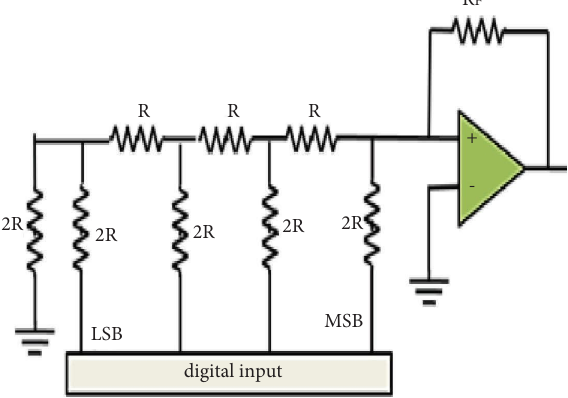
Figure 7: Te R-2R DAC structure.